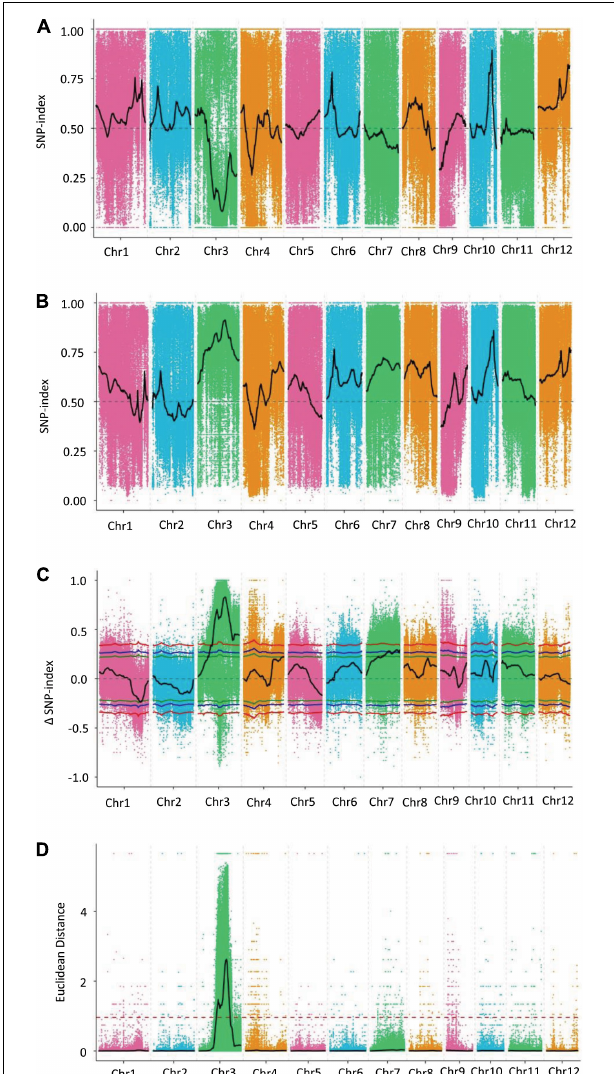
FIGURE 3 | Distribution diagram of the associated values for the SNP index and ED on chromosomes. (A) Distribution diagram of the associated value for the SNP index of the L-pool. (B) Distribution diagram of the associated value for the SNP index of the S-pool. (C) Distribution diagram of the (cid:49) (SNP index) for the S-pool and L-pool. (D) Distribution diagram of the associated value for ED. The colored dots represent the calculated SNP index or the ED value of each SNP site, and the black lines show the fitted SNP index, (cid:49) (SNP index) value, or ED value. In C, the red line shows the association threshold value of 99%, the blue line shows the association threshold value of 95%, and the green line shows the association threshold value of 90%. In (D) , the red dashed line represents the significance association threshold of 0.9650. A higher ED value indicates a better association effect.